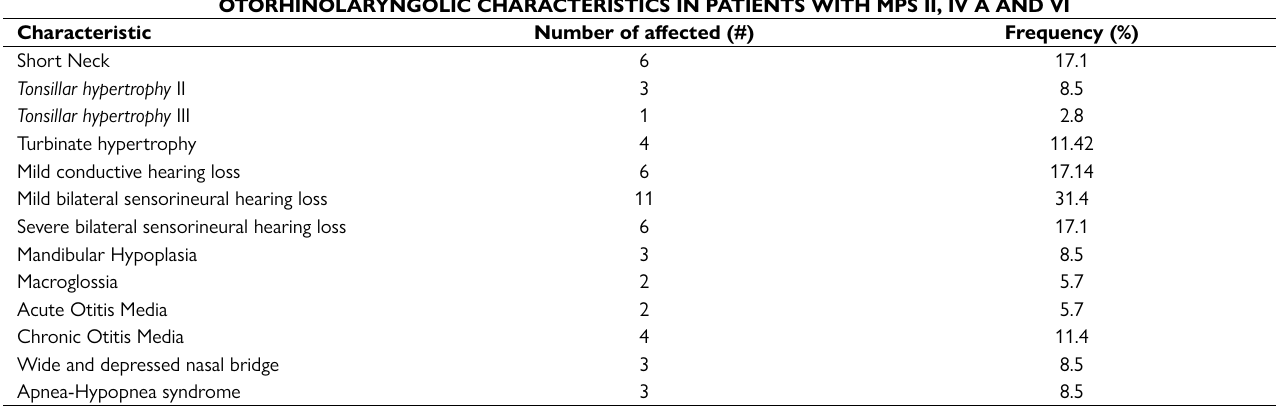
Table 2. Frequency of signs and symptoms in patients with MPS. It is observed that the greater number of affected has been diagnosed with Mild bilateral sensorineural hearing loss, obtaining a frequency of 31,% of all patients. Tonsillar hypertrophy II was the diagnosis with the lowest frequency (2.8%).